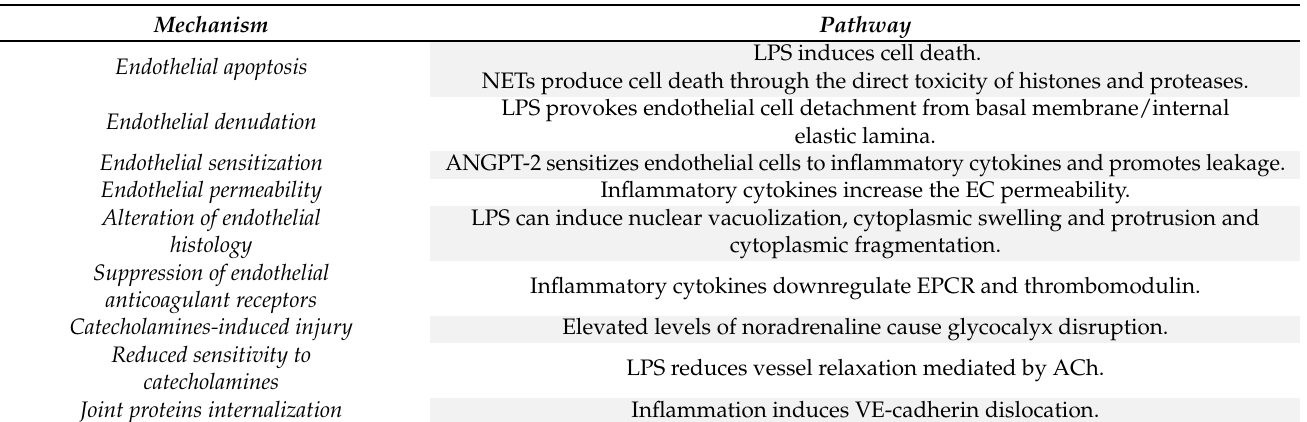
Table 1. Mechanisms involved in endothelial damage in